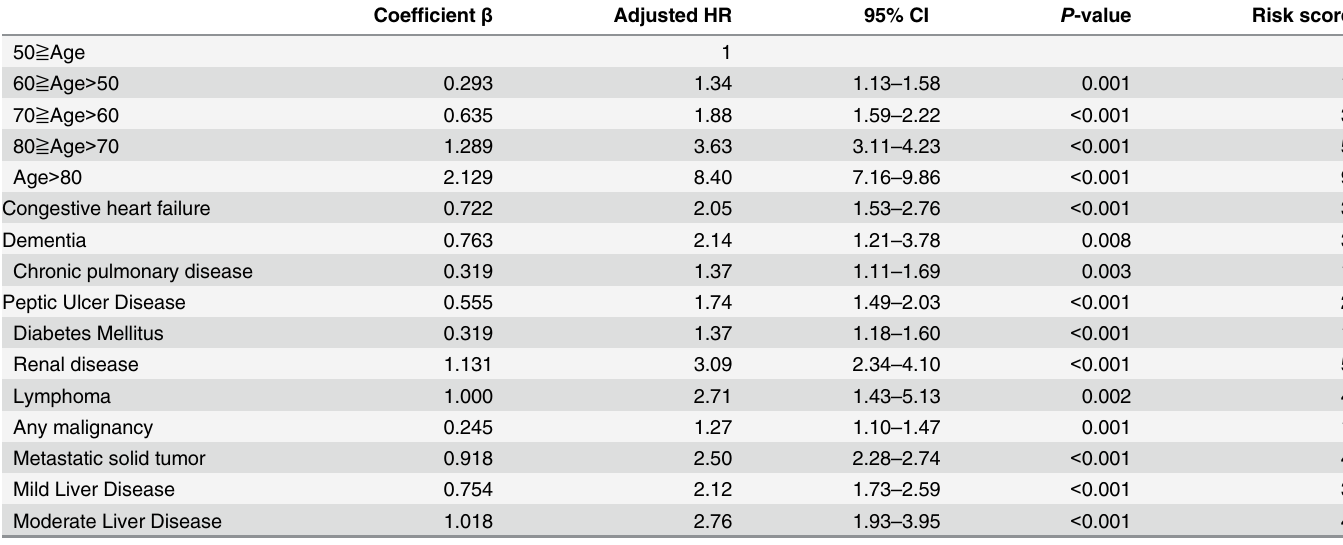
Table 2. Development of the predictor score based on multivariate logistic regression analysis of the derivation set, n = 78,076.